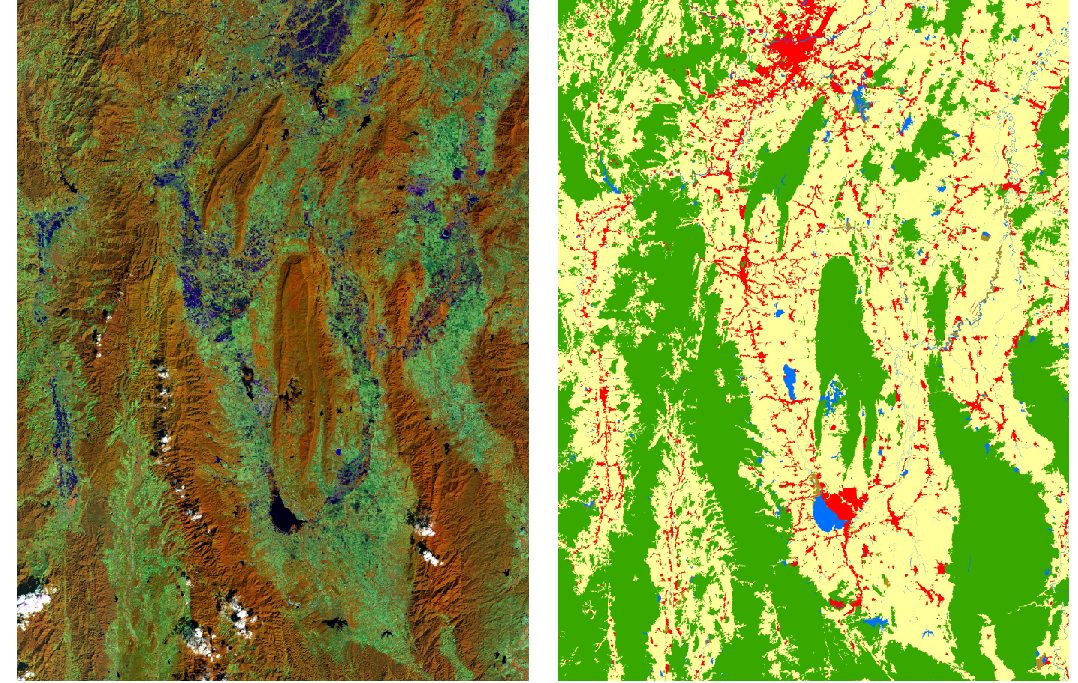
Figure 7. The example of satellite images from Landsat-8w5c corpus, northern province (left) and target image (right). The ground-truth of medium resolution data set includes five classes: urban (red), forest (green), water (blue), agriculture or harvested area (yellow), and miscellaneous or misc